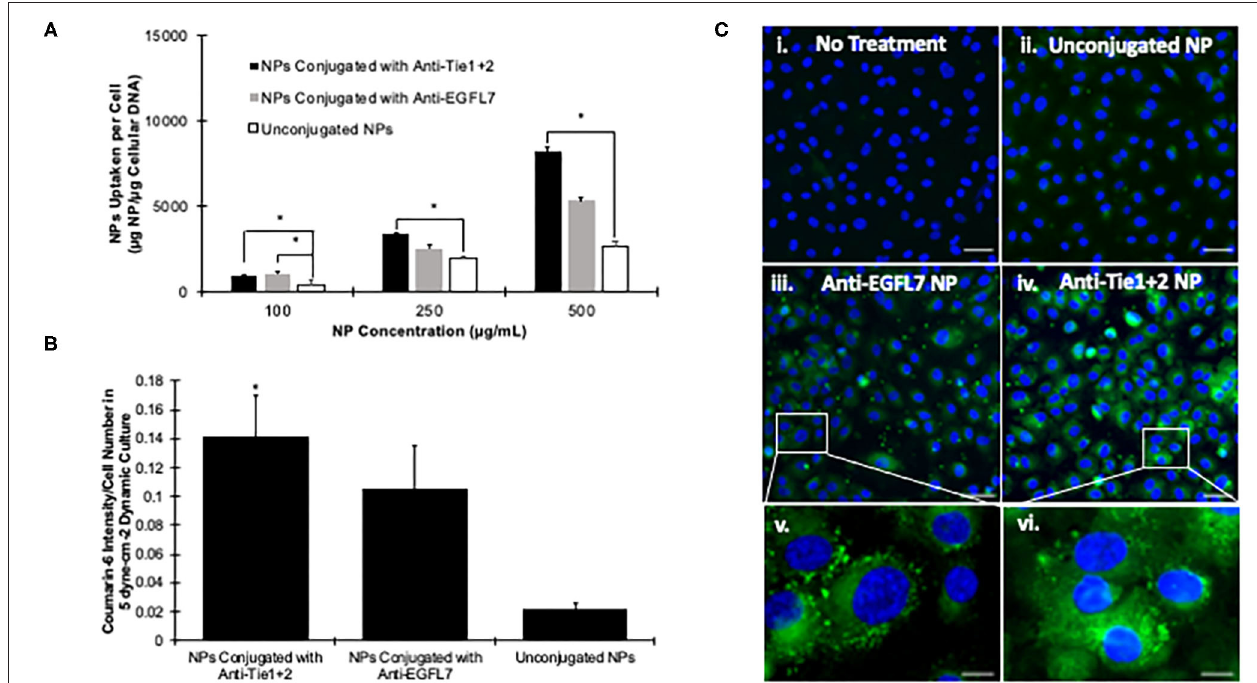
FIGURE 4 | Targeting efficiency of antibody conjugated PLGA nanoparticles. (A) HUVEC Cellular uptake of endothelium specific anti-EGFL7, anti-Tie2 + Tie1 conjugated nanoparticles or unconjugated nanoparticles after 4h. *Indicates a significant difference via one-way ANOVA ( p < 0.05). Data is shown as mean + standard deviation. (B) HUVEC Cellular uptake under 5 dyne · cm − 2 of endothelium specific anti-EGFL7 and anti-Tie1 + 2 conjugated nanoparticles, or unconjugated nanoparticles. *Denotes a significant difference between anti-Tie2 + Tie1 nanoparticles and unconjugated nanoparticles via one-way ANOVA ( p < 0.05). Data is shown as mean + standard deviation. (C) Fluorescent images of HUVEC’s incubated in flow culture of 5 dyne · cm − 2 with (i) No Treatment, (ii) Unconjugated Nanoparticles, (iii) Anti-EGFL7 conjugated nanoparticles, (iv) anti-Tie1 + 2 conjugated nanoparticles. Scale bar = 20 µ m. Zoomed in portions of HUVEC’s incubated in flow culture at 5 dyne · cm − 2 with (v) Anti-EGFL7 conjugated nanoparticles, and (vi) anti-Tie2 + Tie1 conjugated nanoparticles. Scale bar = 5 µ m.